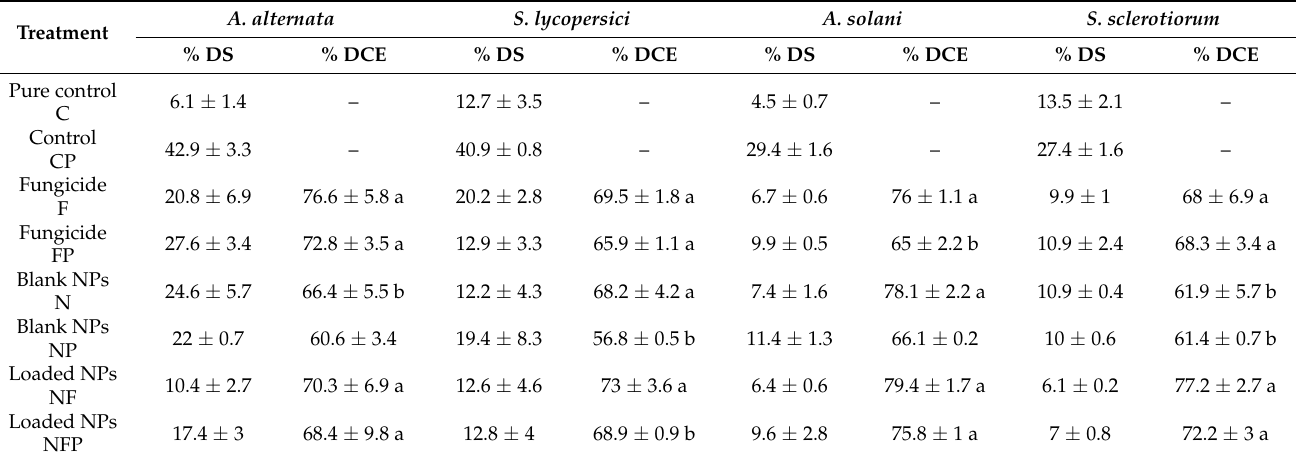
Table 5. Percentage disease severity (%DS) and percentage disease control efficacy (%DCE) of nanofor-mulations (CSCRG-1.0) in pot house